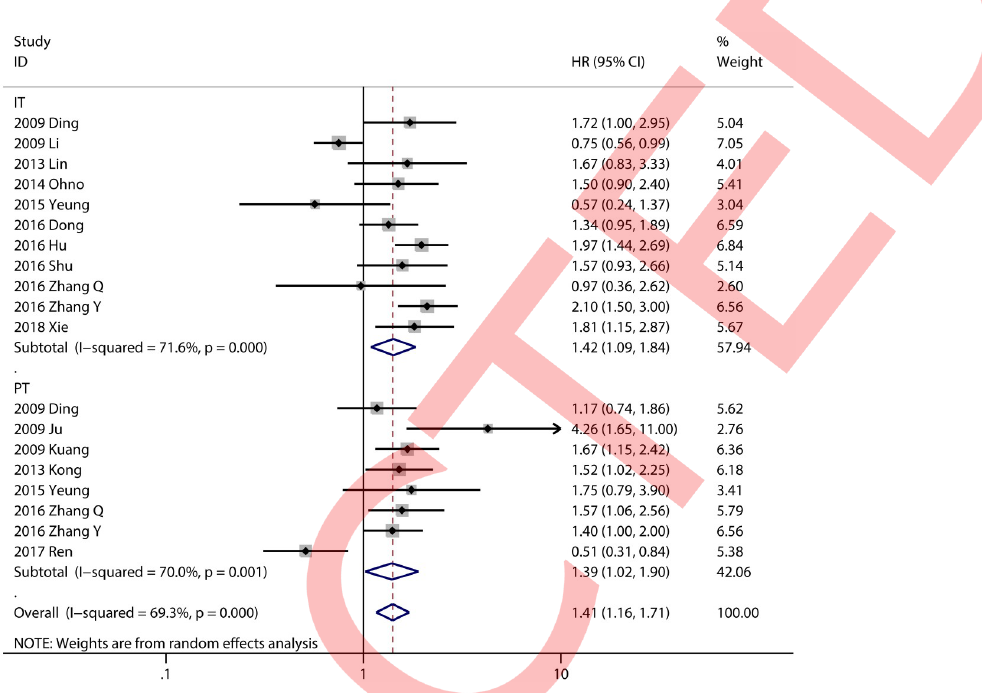
Fig 2. Forest plots of studies evaluating the association between CD68+ TAMs and OS of HCC patients.